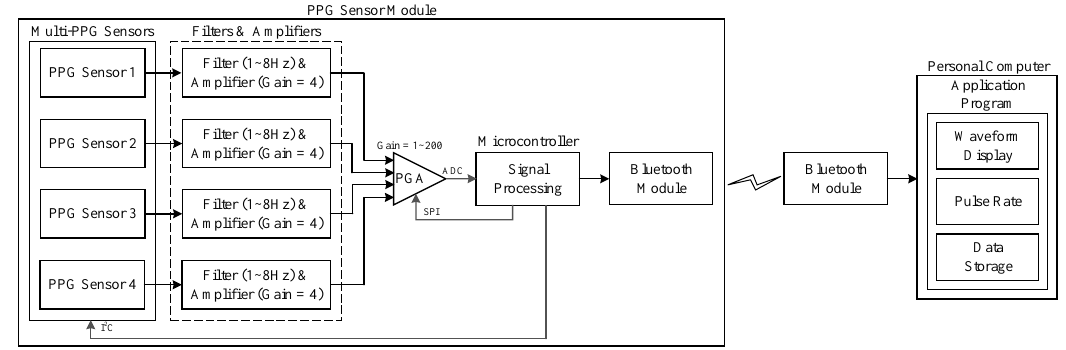
Figure 1. System structure.